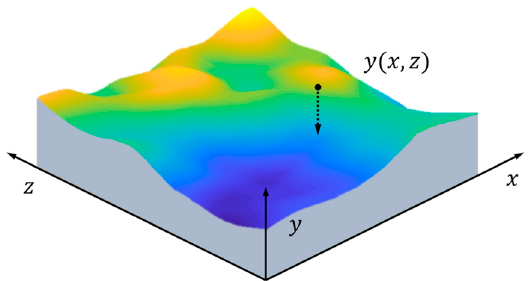
Figure 1. A 3D model of a substrate with a rough surface.